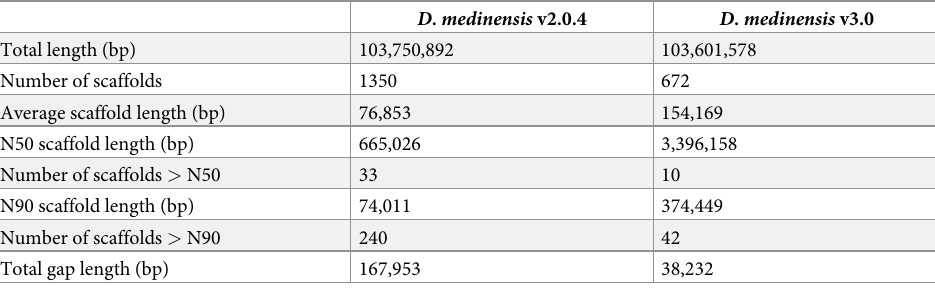
Table 1. Assembly statistics for Dracunculus medinensis assembly